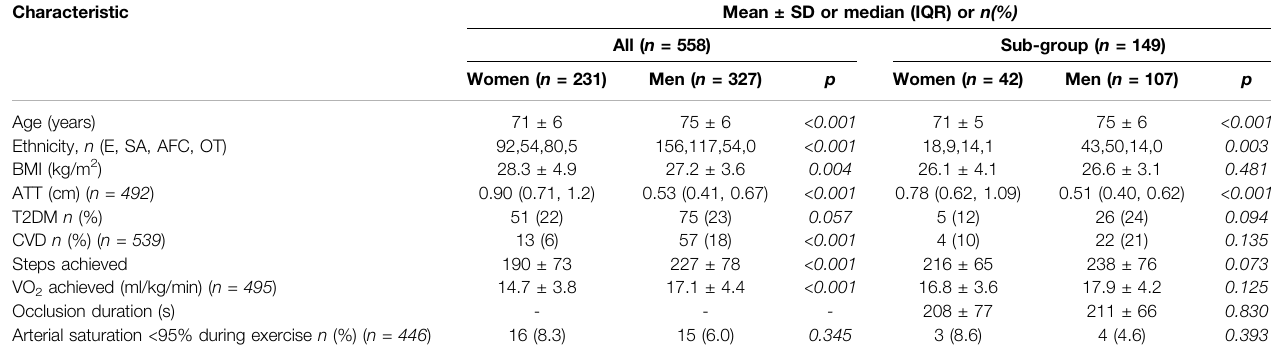
TABLE 1 | Participant characteristics strati fi ed by sex. Values are mean ± SD or median (inter-quartile range) for the whole study group and those who undertook an ischaemic occlusion. ATT, adipose tissue thickness at the NIRS measurement site, BMI, body mass index, CVD, cardiovascular disease, ethnicity is E, European; SA, South Asian ; AFC, African Caribbean or OT, Other; T2DM, type-2 diabetes mellitus.